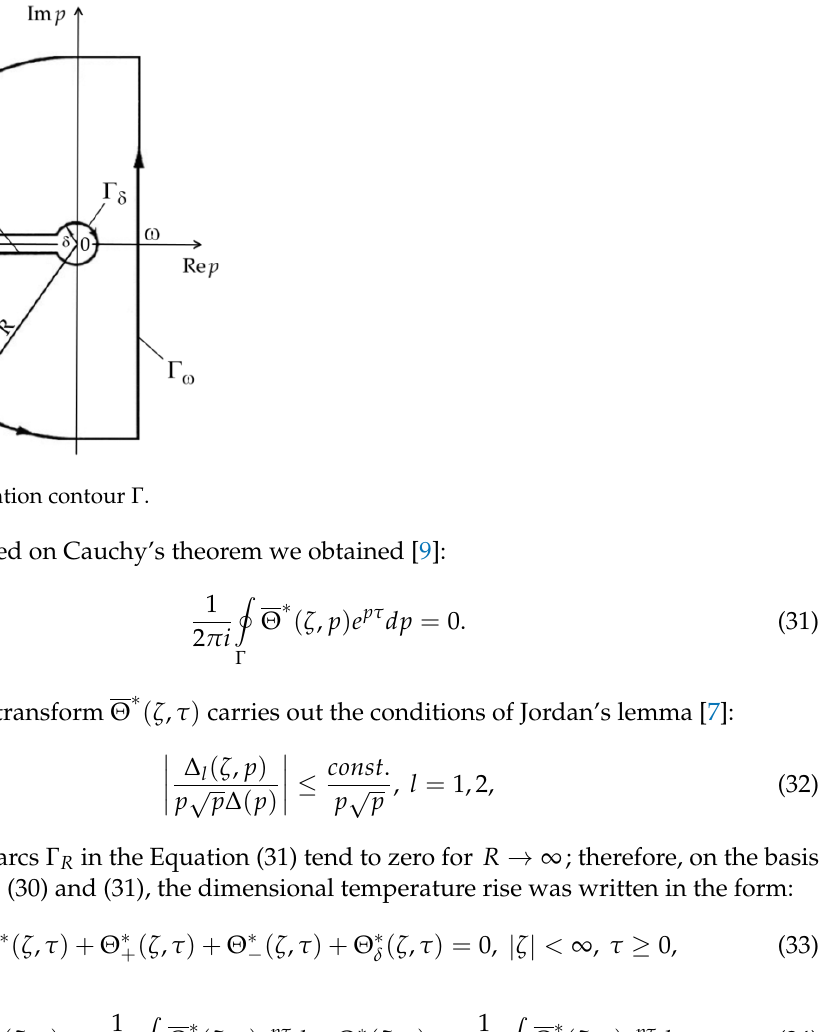
Figure 2. The contour Γ consists of the straight line